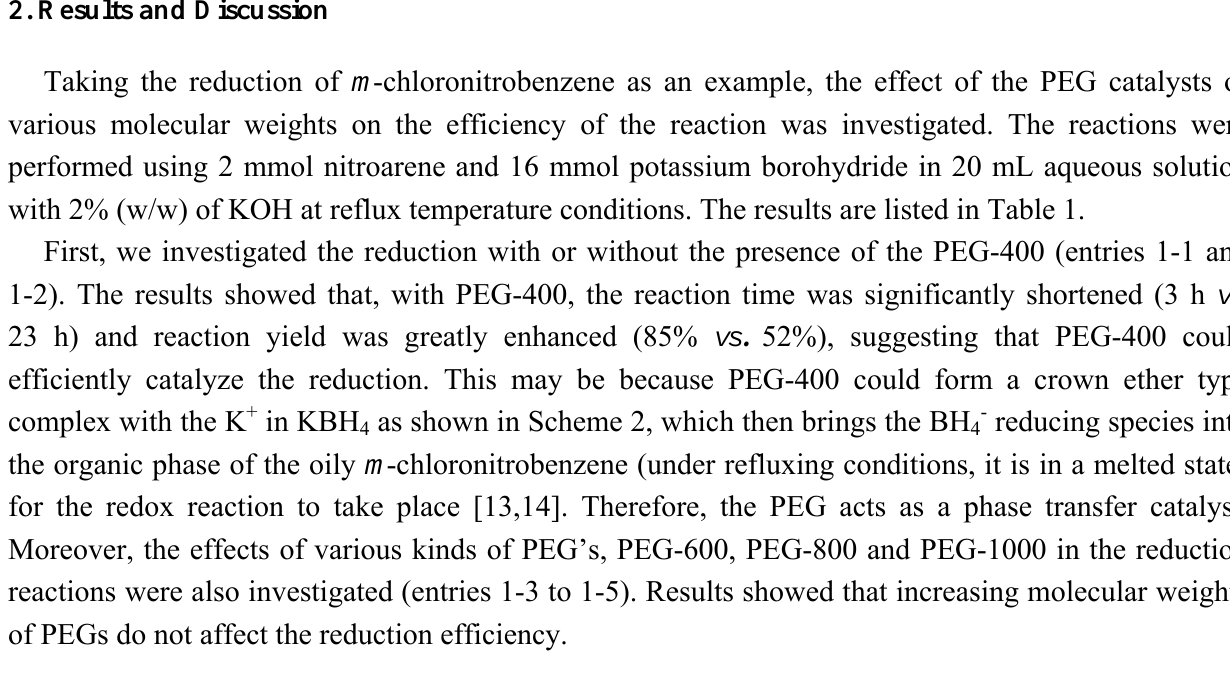
Table 1. Effects of PEGs on the reduction reaction of m